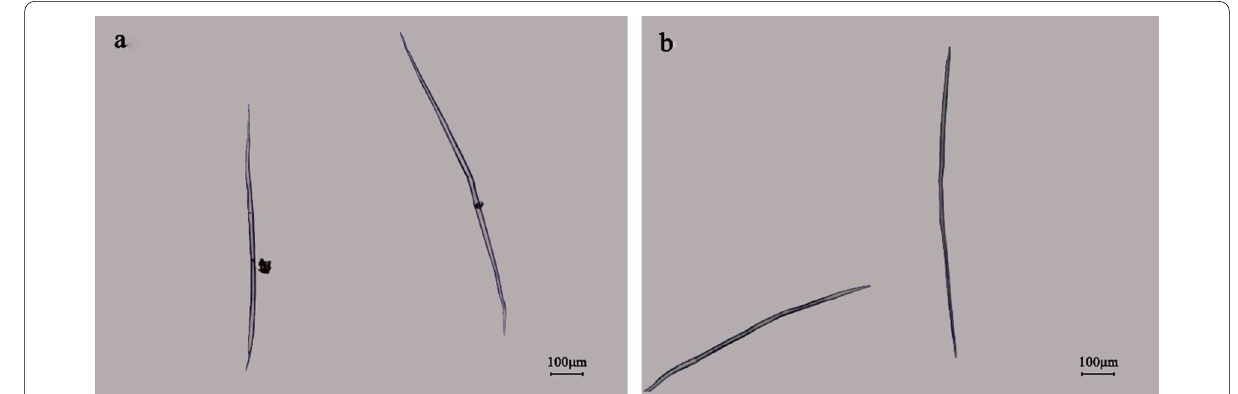
Fig. 4 Fiber morphology of materials. a Fiber morphology of poplar. b Fiber morphology of chestnut bur